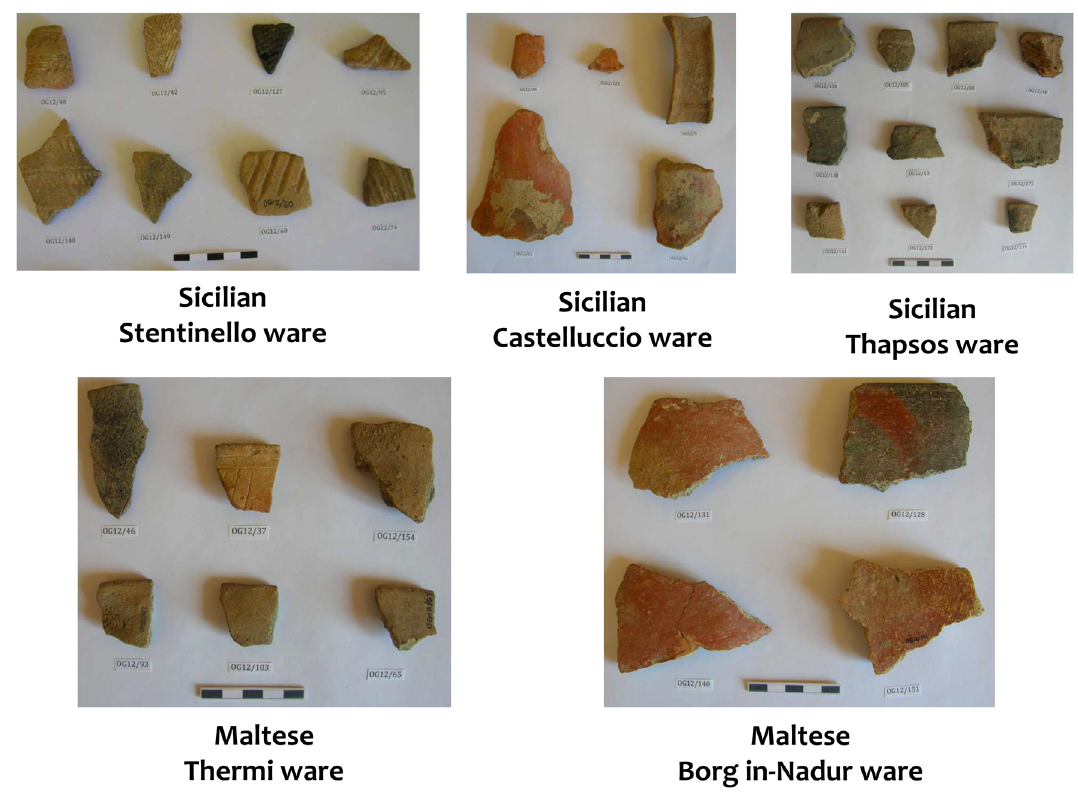
Figure 2. Prehistoric pottery classes from Ognina (fieldwork 2012): Stentinello, Castelluccio, Thapsos, Thermi Ware and Borġ in-Nadur ware (photo Davide